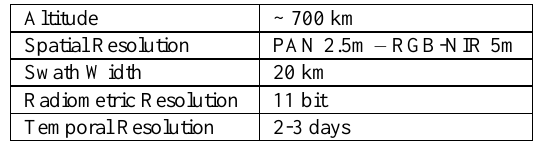
Table 2. Technical specifications of GÖKTÜRK-2